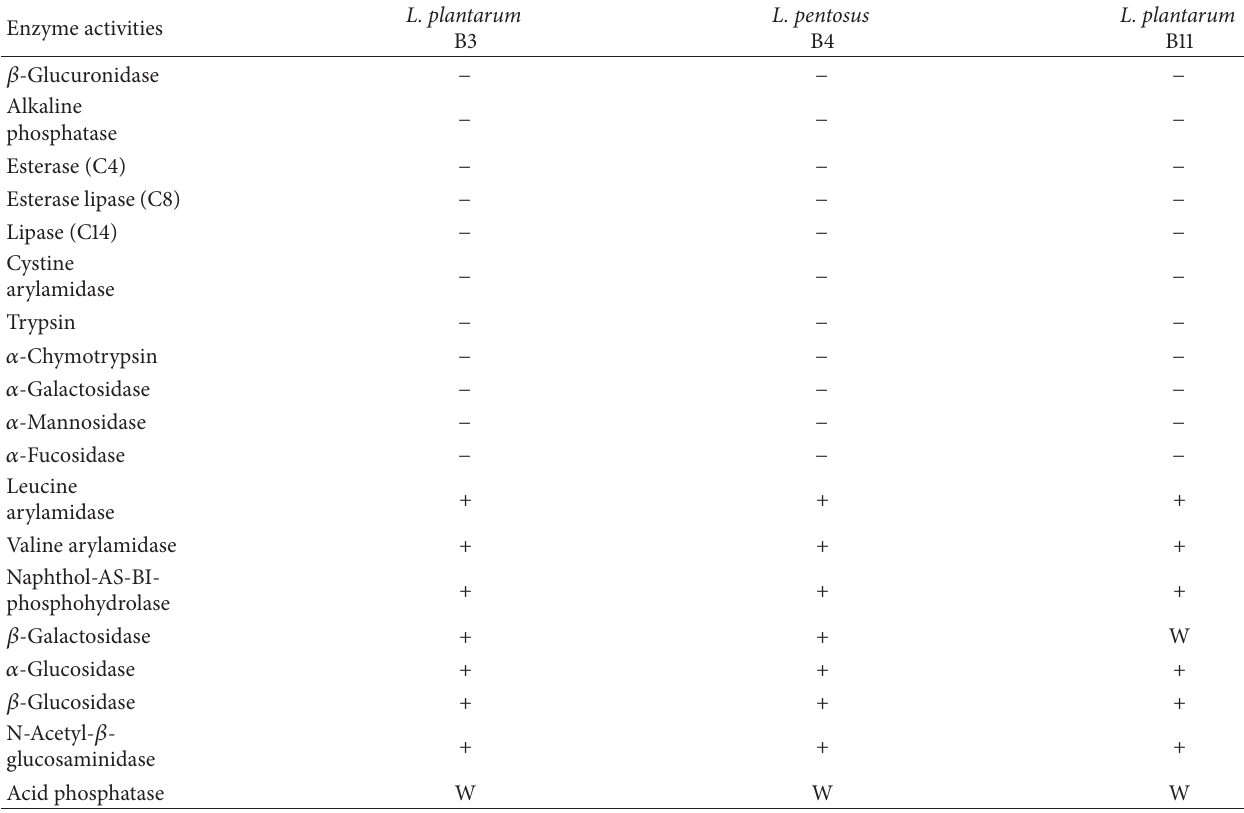
Table 2: Api-Zym galleries of enzymatic activities corresponding to the Lactobacillus tested strains ((+) positive; (W) weakly positive; ( − )